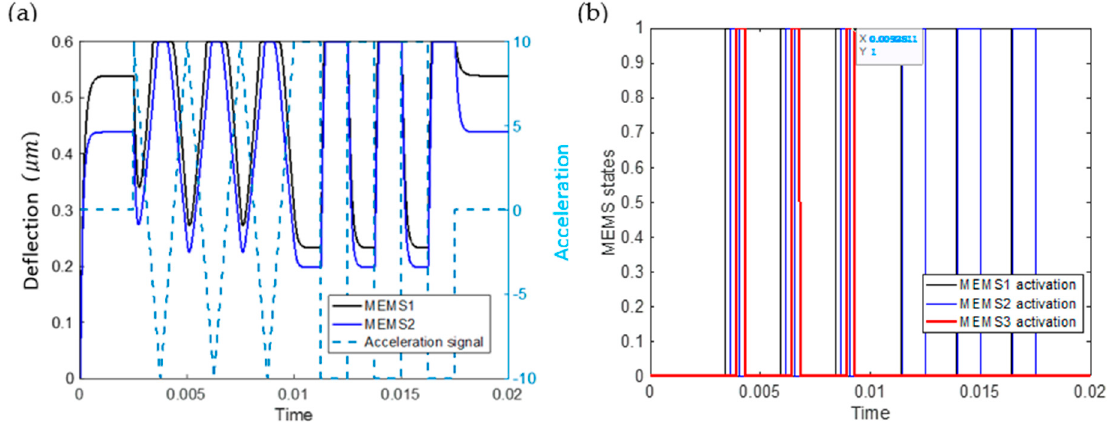
Figure 9. Simulation results for the customized MEMS CTRNN to classify square signal from triangle signal. ( a ) The deflection of the two input MEMS neuron and input acceleration signal. ( b ) the status of the three MEMS neurons, where the status of MEMS3 is considered the network output. The state of the MEMS device is considered to be 1 if pulled-in and 0 otherwise. By the end of each waveform cycle, MEMS3 is correctly on when the input signal is a triangle and is Off when the input signal is a square.